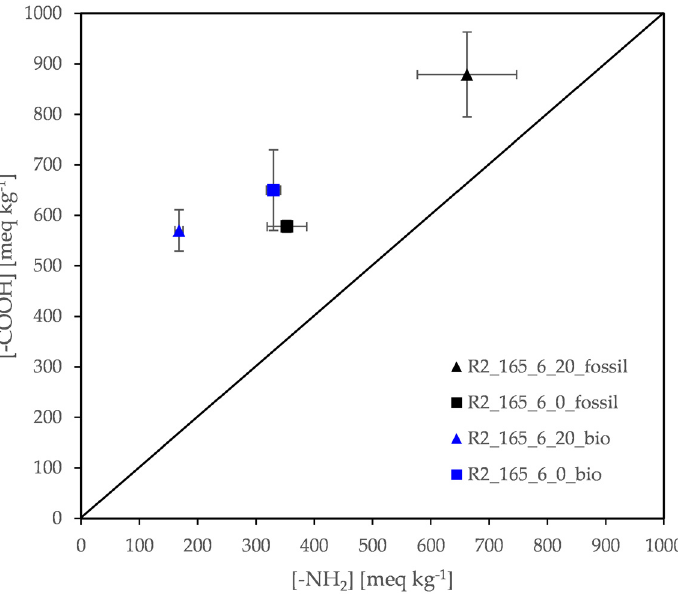
Figure 11. Effect of nitrogen flow rate: amine and carboxyl end group concentration of DSSP prod- ucts.